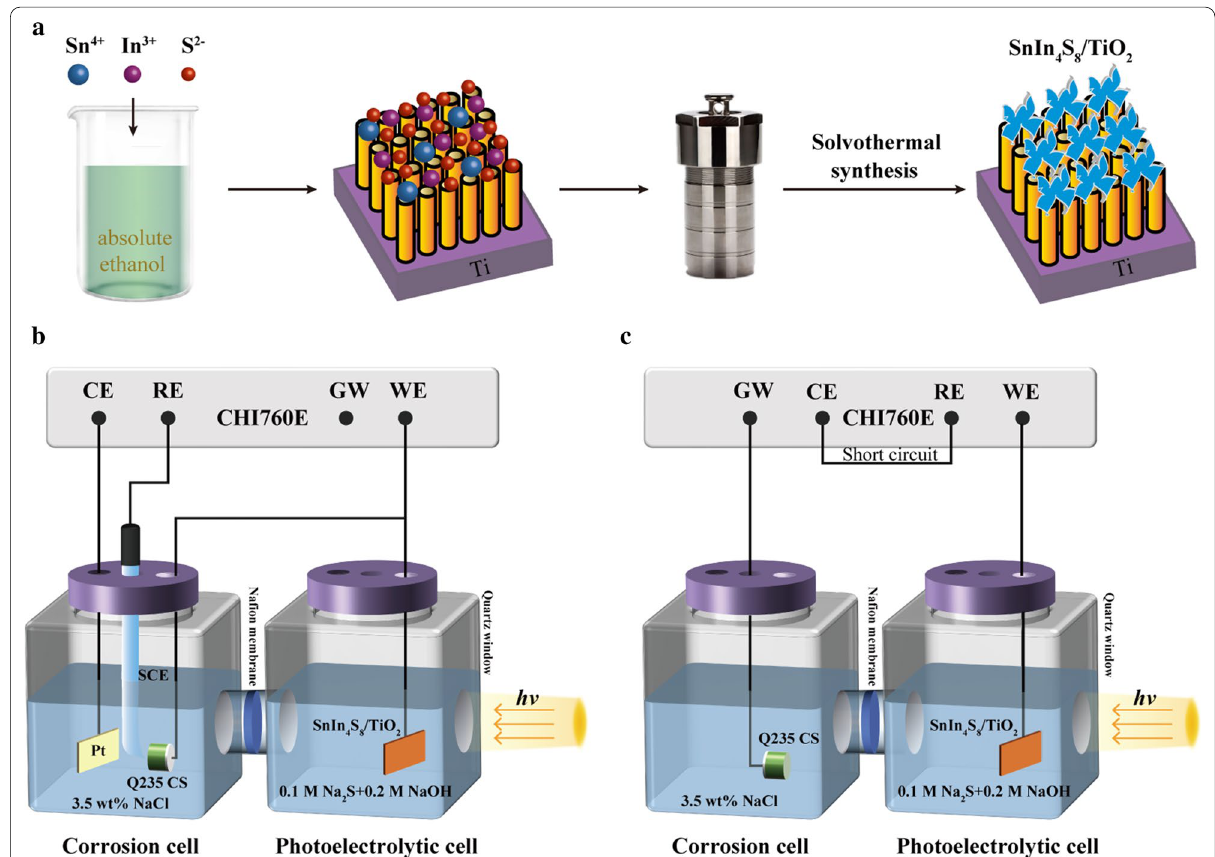
Fig. 1 a Schematic illustration of the synthetic process for the preparation of the SnIn 4 S 8 /TiO 2 composite film; schematic illustration of the experimental devices for photoelectrochemical measurements including b OCP variations and c photocurrent density